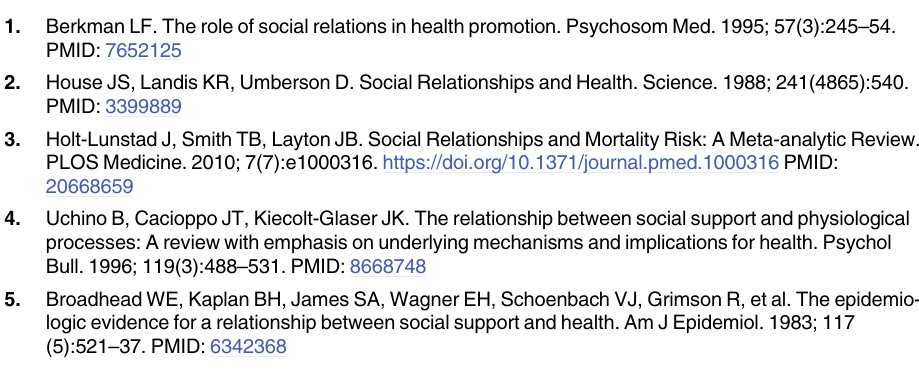
S1 Table. Blood pressure and self-report correlations. Note . Sbp = systolic blood pressure; Dbp = diastolic blood pressure; Hr = pulse rate; STAI = Spielberger state-trait anxiety scale; PT = perceived threat scale; PC = perceived challenge scale; POC = perceptions of control scale. � p <